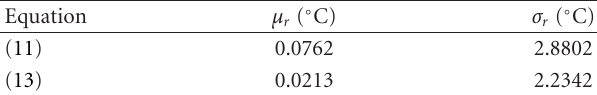
Table 5: Statistics of residuals. Daily average